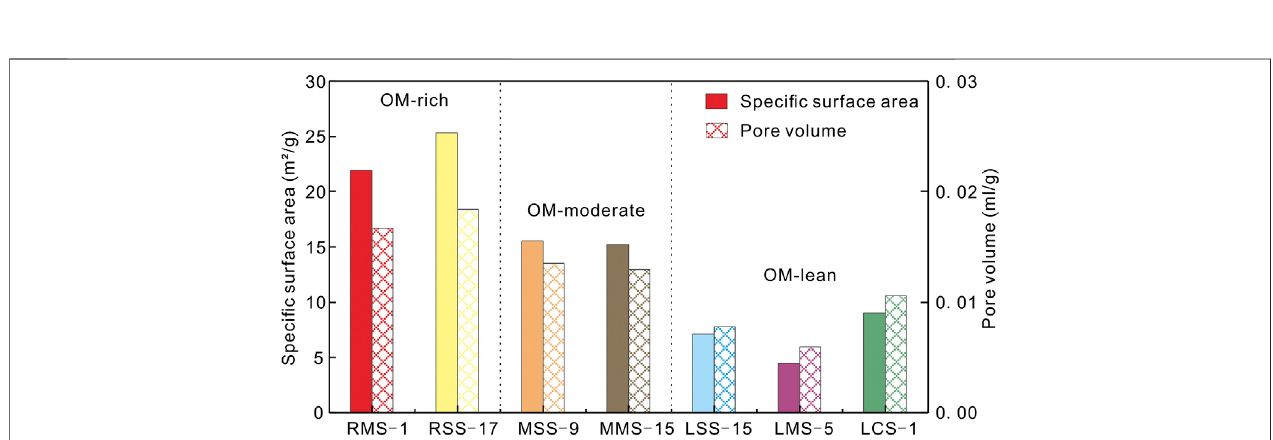
FIGURE 4 | Nitrogen gas adsorption/desorption (A – C) and carbon dioxide adsorption (D – F) isotherms of the Longmaxi Formation shale. OM-rich mixed shale (RMS); OM-rich siliceous shale (RSS); OM-moderate mixed shale (MMS); OM-moderate siliceous shale (MSS); OM-lean mixed shale (LMS); OM-lean siliceous shale (LSS); OM-lean clay shale (LCS).